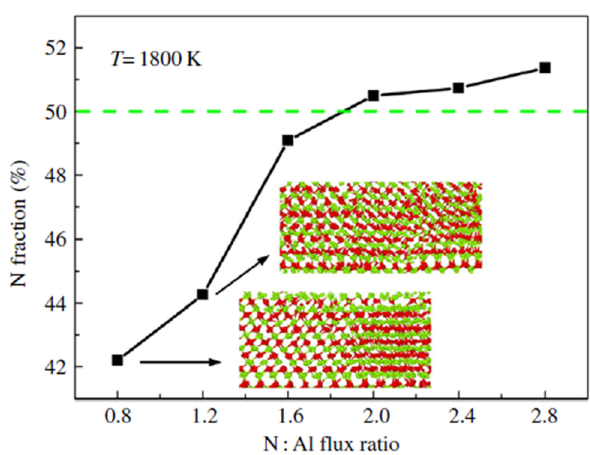
Figure 20: Fraction of nitrogen of deposited fi lms at a temperature of 1,800 K with various nitrogen - to - aluminium fl ux ratios starting at 0.8 – 2.8 [ 195 ] .